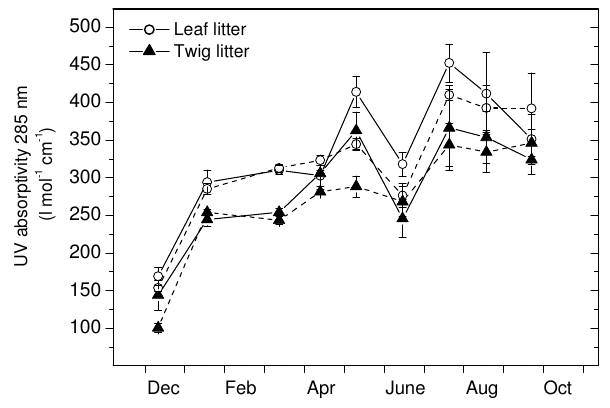
Fig. 7. Specific UV absorptivity of litter-derived C leached from the forest floor in the Rendzina (solid line) and the Cambisol (dashed line). Means and standard errors of five replicates. 3